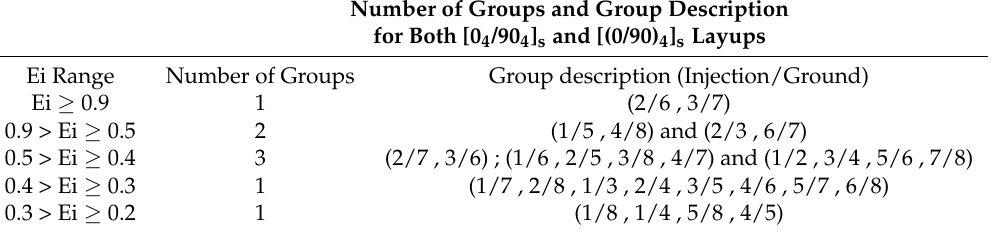
Table 3. Effective Independence value groups for 2D models of [ 0 4 /90 4 ] eight